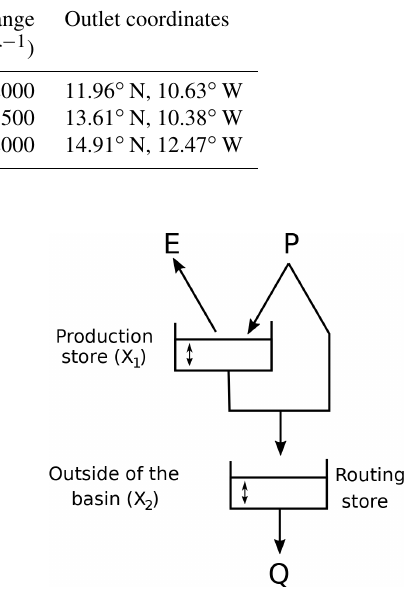
Figure 4. Scheme of the hydrological GR2M